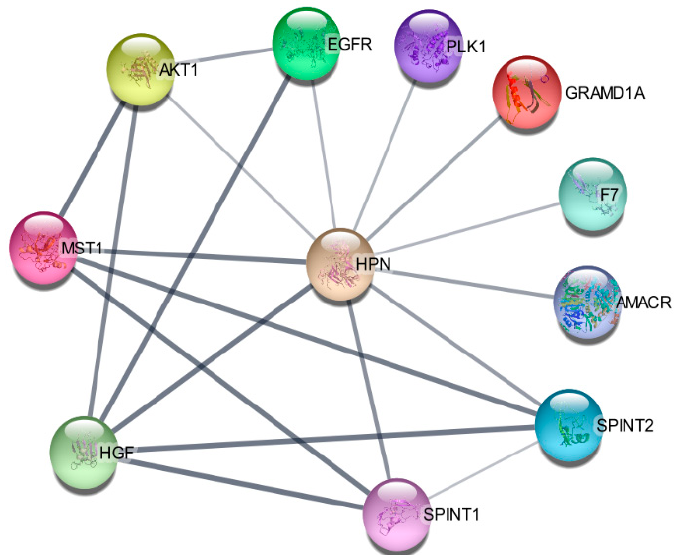
Figure 5. Hepsin protein–protein interaction (PPI) network.